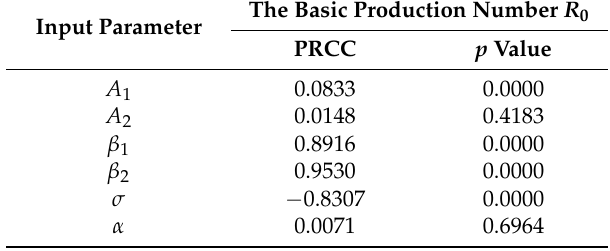
Table 3. Partial rank correlation coefficients (PRCCs) for the aggregate R 0 and each input parameter